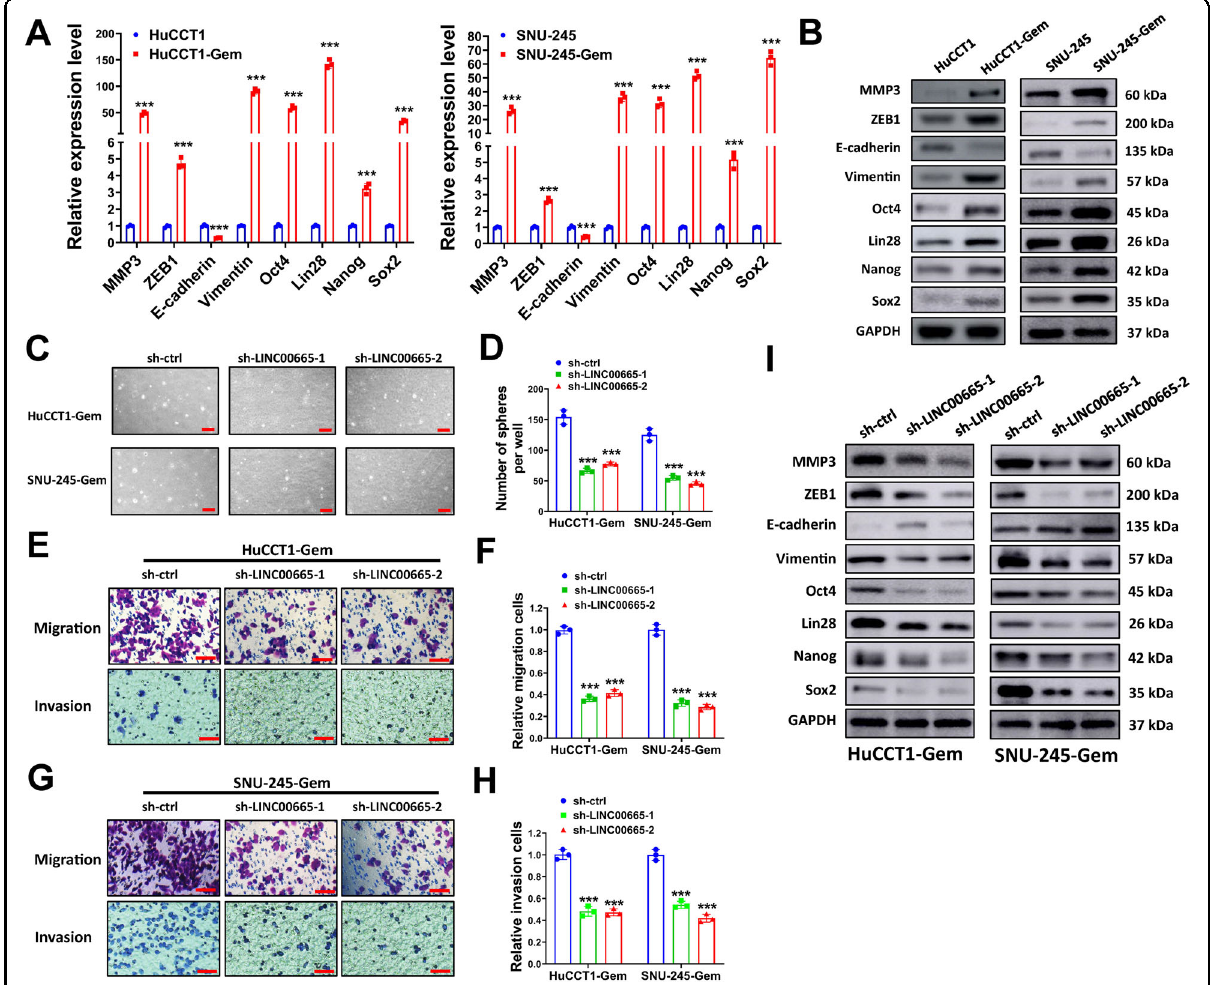
Fig. 4 Silencing LINC00665 suppresses EMT and stemness properties in gemcitabine-resistant CCA cells. A , B relative expression of EMT markers (MMP3, ZEB1, E-cadherin, and Vimentin) and CSC markers (Oct4, Lin28, Nanog and Sox2) in resistant or sensitive CCA cells were evaluated by qRT-PCR ( A ) or western blot ( B ). C – H HuCCT1-Gem and SNU-245-Gem cells transduced with sh-LINC00665-1, sh-LINC00665-2, or sh-ctrl were used for sphere formation assay ( C , D ), and transwell cell migration and invasion assays ( E – G ). Represent images of tertiary spheres ( C ) and migration or invasion cells ( E , G ), and a number of spheres ( D ) and relative migration or invasion cells ( F , H ) were shown. I HuCCT1-Gem and SNU-245-Gem cells were transduced with sh-LINC00665-1, sh-LINC00665-2, or sh-ctrl, then cell lysates were collected for western blot. Scale bars = 100 μ m for sphere formation assay, and scale bars = 50 μ m for transwell cell migration and invasion assay. *** P ≤